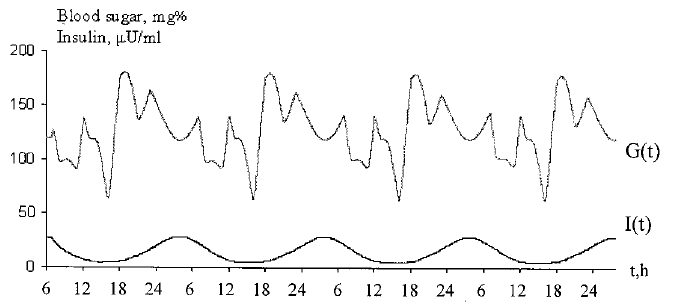
Figure(cid:5)(cid:1)Regularinsulininjected(cid:12)timesbeforeameal(cid:8)